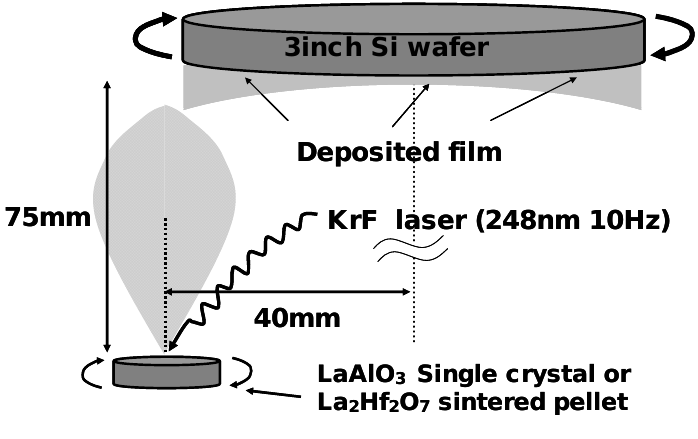
Figure 19. Schematic representation of the PLD system used in the experiments. The film thickness increases with the distance from the center of the